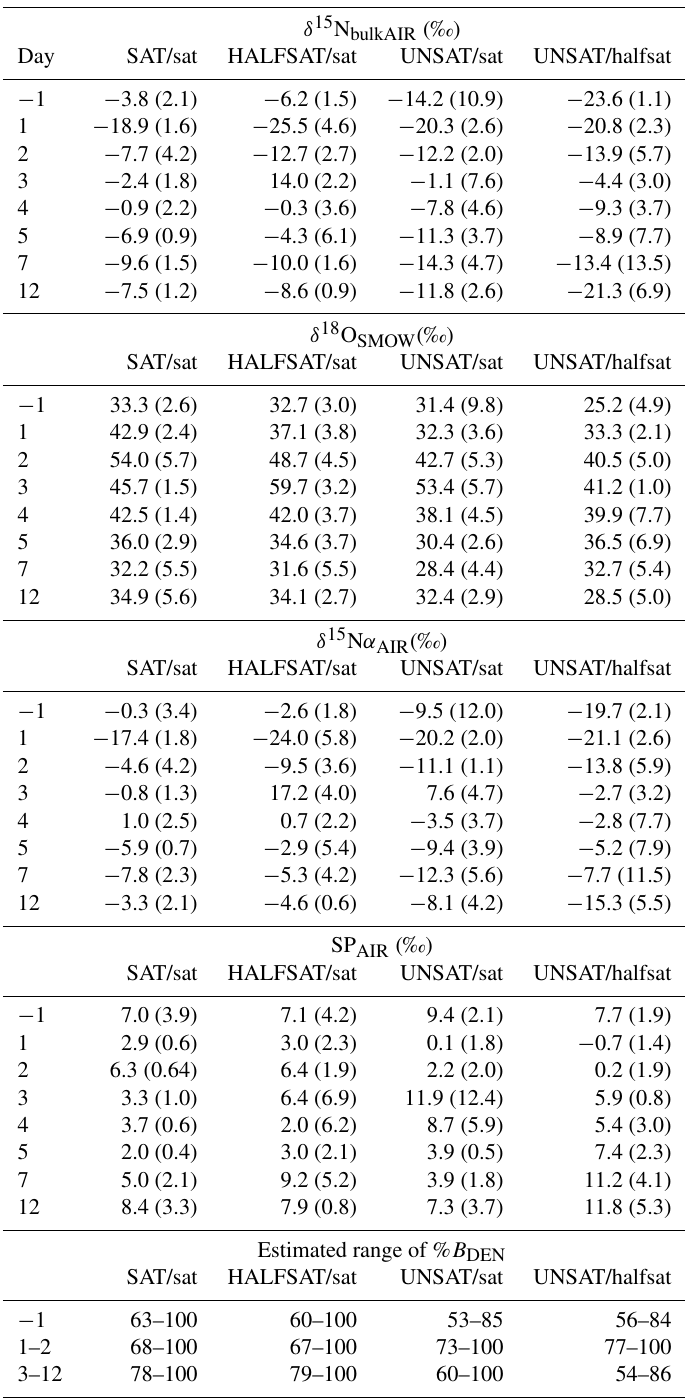
Table 6. The temporal trends in δ 15 N bulk , δ 18 O, δ 15 N α , site preference (SP) and % B DEN for all experimental treatments (values in brackets are the standard deviation of the